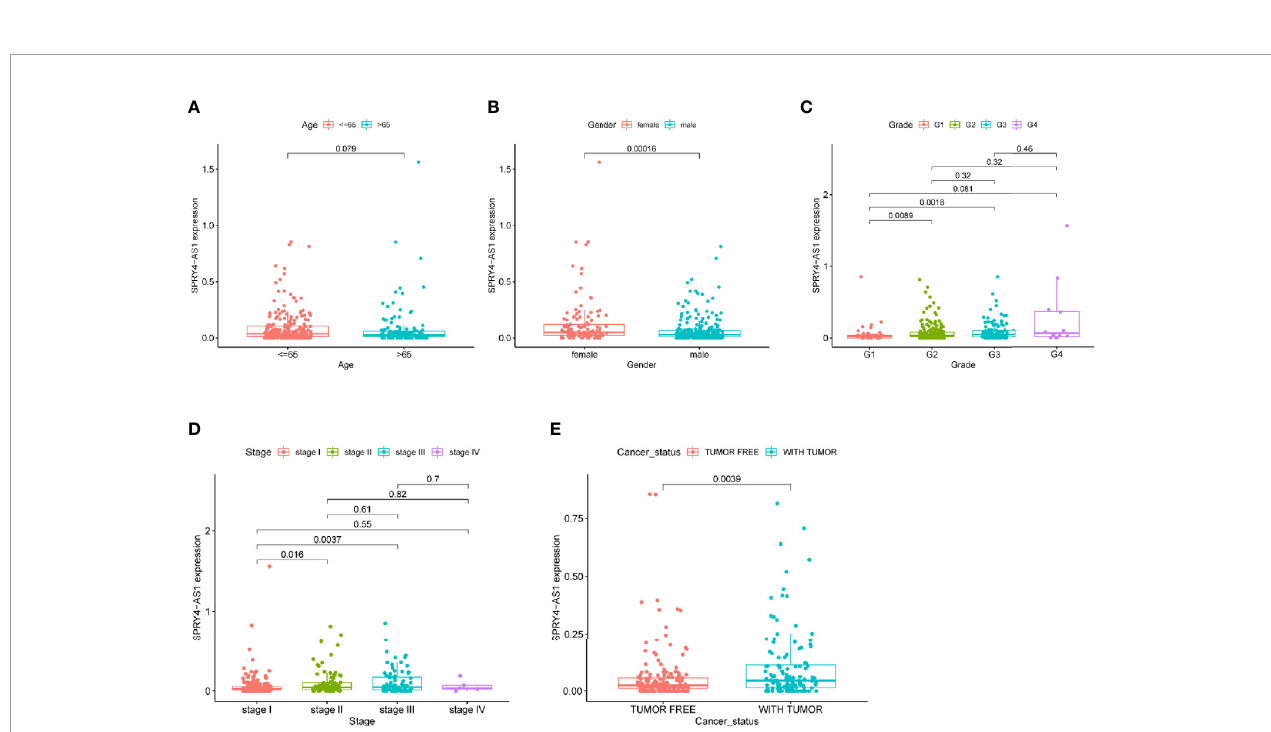
FIGURE 2 | The associations between SPRY4 antisense RNA 1 (SPRY4-AS1) and clinical features. (A) Age. (B) Gender. (C) Grade. (D) Stage. (E) Cancer status.